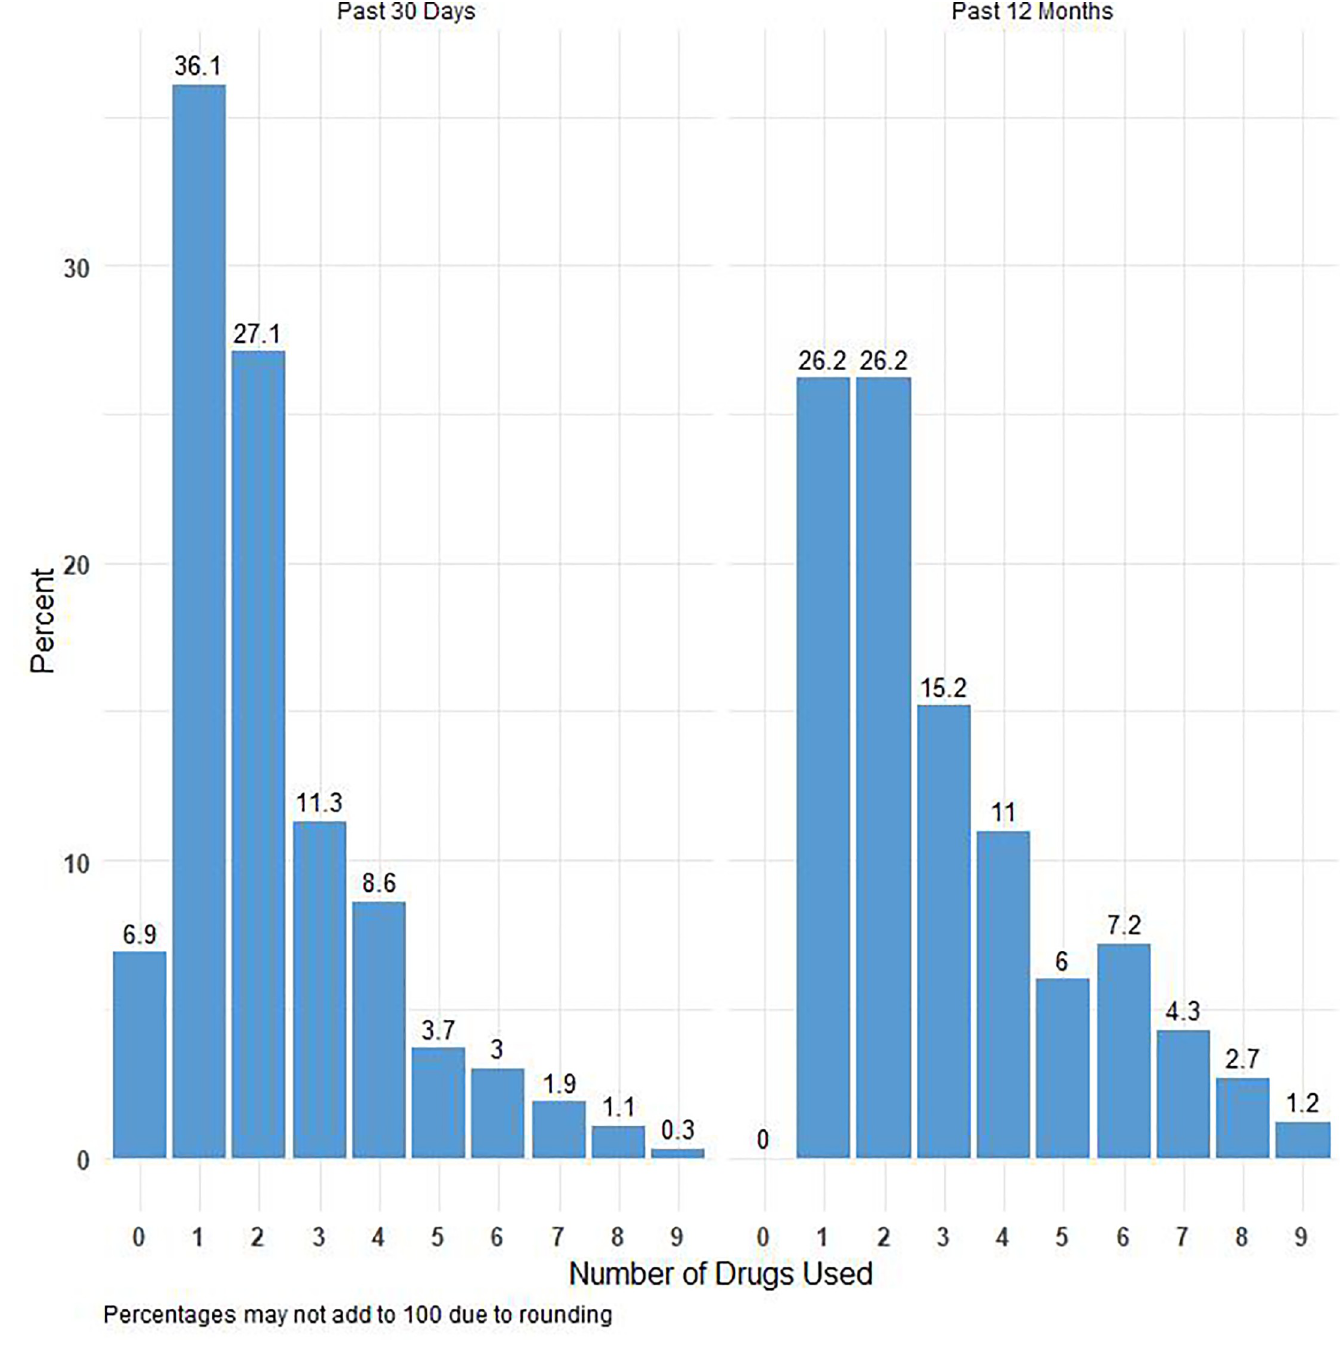
Fig 1. Poly drug use past 30 days and past 12